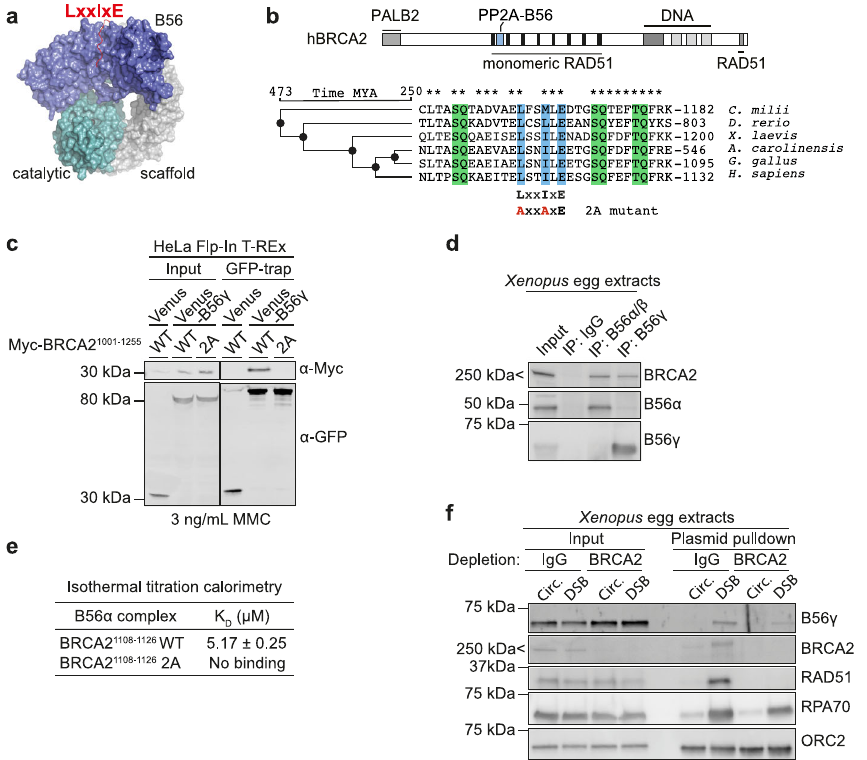
Fig. 1 BRCA2 binds PP2A-B56 through a conserved LxxIxE motif and recruits it to DSBs. a Model of the PP2A-B56 holoenzyme with an LxxIxE motif- containing peptide bound generated using PyMOL. b Top: Domain organization of human BRCA2 with selected interaction domains and the PP2A-B56 binding region indicated. Bottom: Conservation of the PP2A-B56-binding region in BRCA2. A Clustal Omega multiple sequence alignment of vertebrate BRCA2 protein sequences is shown with LxxIxE motif marked in blue and SQ/TQ sites in green. The sequence of the 2A mutation is shown. Asterisks (*) indicate conserved residues. Evolution tree using the TimeTree database 63 (timetree.org) is shown. MYA, million years ago. c Western blot of the co- immunoprecipitation of Myc-BRCA2 1001 – 1255 WT or 2A with Venus or Venus-B56 γ from HeLa Flp-In T-REx cells in presence of 3 ng/mL Mitomycin C (MMC). Representative of three independent experiments. d Western blot of the co-immunoprecipitation of BRCA2 with B56 subunits from Xenopus egg extracts representative of two independent experiments. IP, immunoprecipitation. e Dissociation constants (K D ) for the interactions between the indicated BRCA2 peptides and B56 α measured by isothermal titration calorimetry. f Western blot of a pulldown of an intact circular (Circ.) or linearized DSB- containing plasmid from mock (IgG) or BRCA2 immunodepleted Xenopus egg extracts representative of two independent